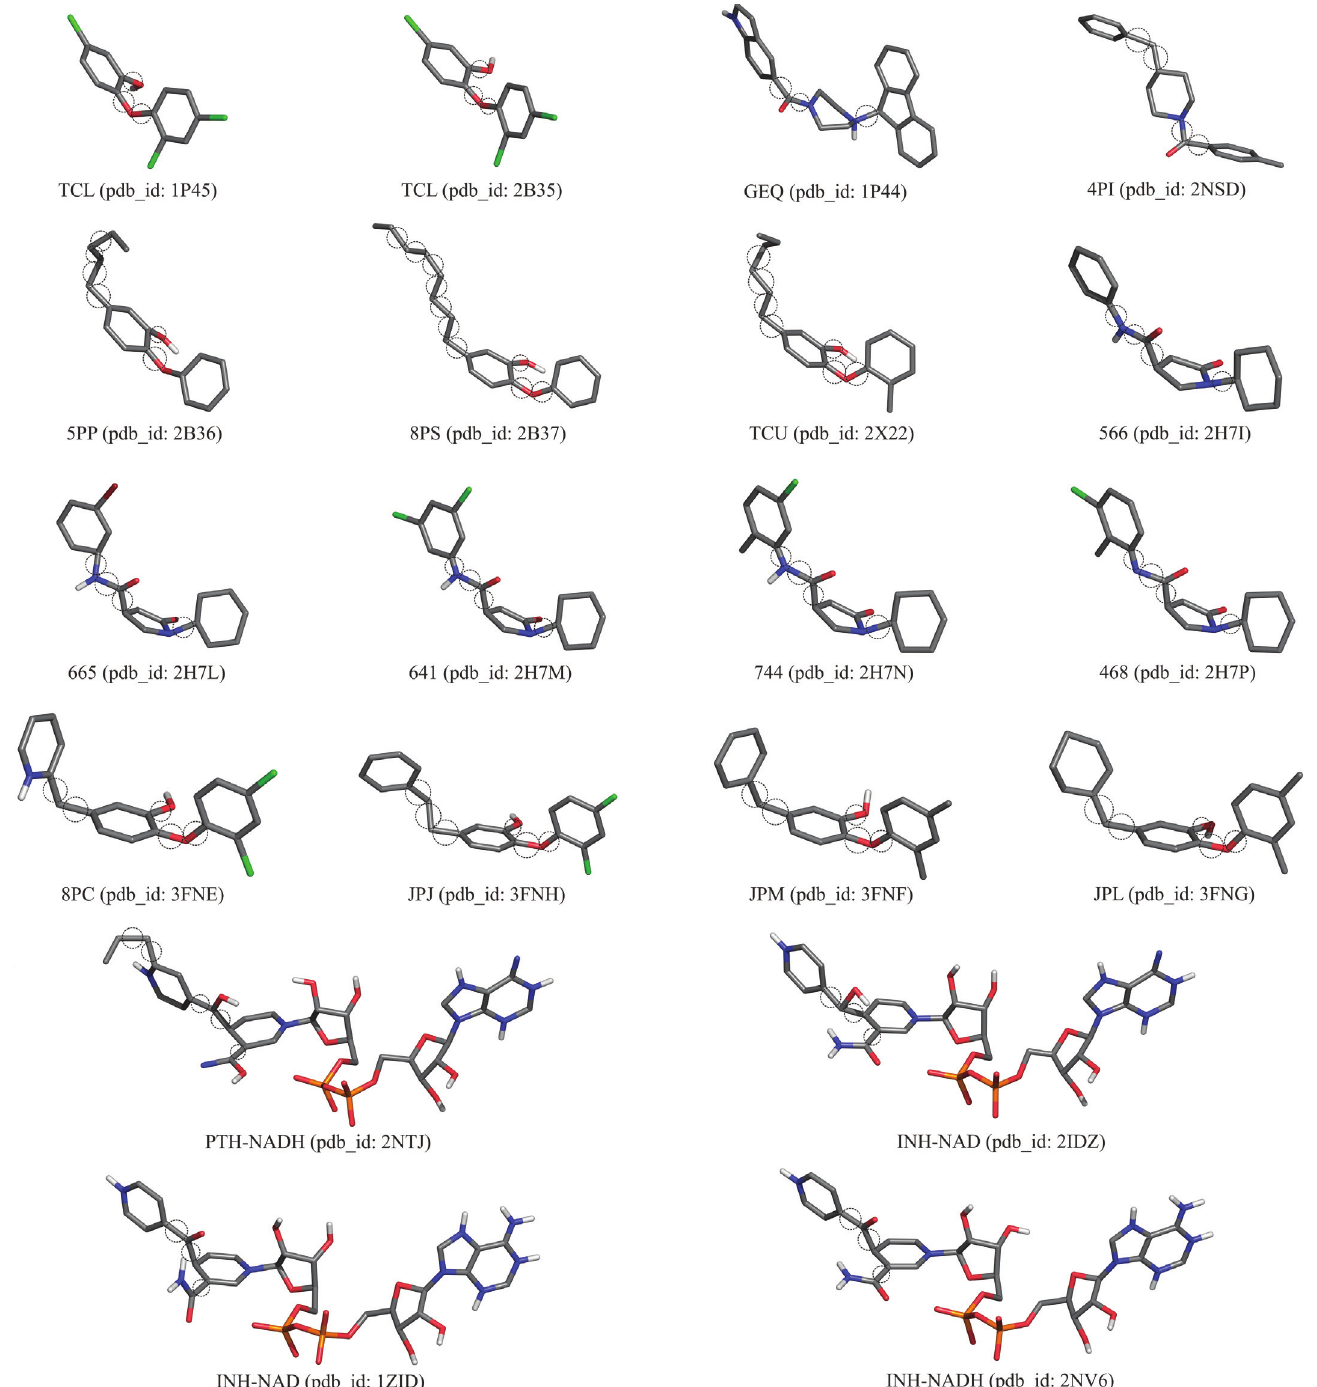
Fig 3. 3D structure of the 20 ligands used in docking experiments. Each ligand is colored by atom type (carbon and hydrogen: light grey; nitrogen: blue; oxygen: red; chloro: green; phosphorus: orange; sulphur: yellow) and displays its name and PDB identification (PDB ID). The dashed circle represents the rotatable bounds selected by AutoDockTools 1.5.6. Ligand Abbreviations: TCL : triclosan; 665: (3S) N-(3-bromophenyl)-1-cyclohexyl-5-oxopyrrolidine- 3-carboxamide; 566: (3S)-1-cyclohexyl-5-oxo-N-phenyl pyrrolidine-3-carboxamide; 8PC: 2-(2,4-dichloro-phenoxy)-5-(pyridin-2-ylmethyl)phenol; JPJ: 2- (2,4-dichlorophenoxy)-5-(2-phenylethyl)phenol; JPL: 5-(cyclohexa-1,5-dien-1-ylmethyl)-2-(2,4-dichlorophenoxy) phenol; JPM: 5-benzyl-2- (2,4-dichloropheno-xy)phenol; 468: (3S)-N-(3-chloro-2-methylphenyl)-1-cyclohe xyl-5-oxopyrrolidine-3-carboxamide; 641: (3S)-1-cyclohexyl-N- (3,5-dichlorophenyl)-5-oxopyrrolidine-3-carboxamide; 744: (3S)-N-(5-chloro-2-me-thylphenyl)-1-cyclohexyl-5-oxopyrrolidine-3-carboxamide; INH-NAD: